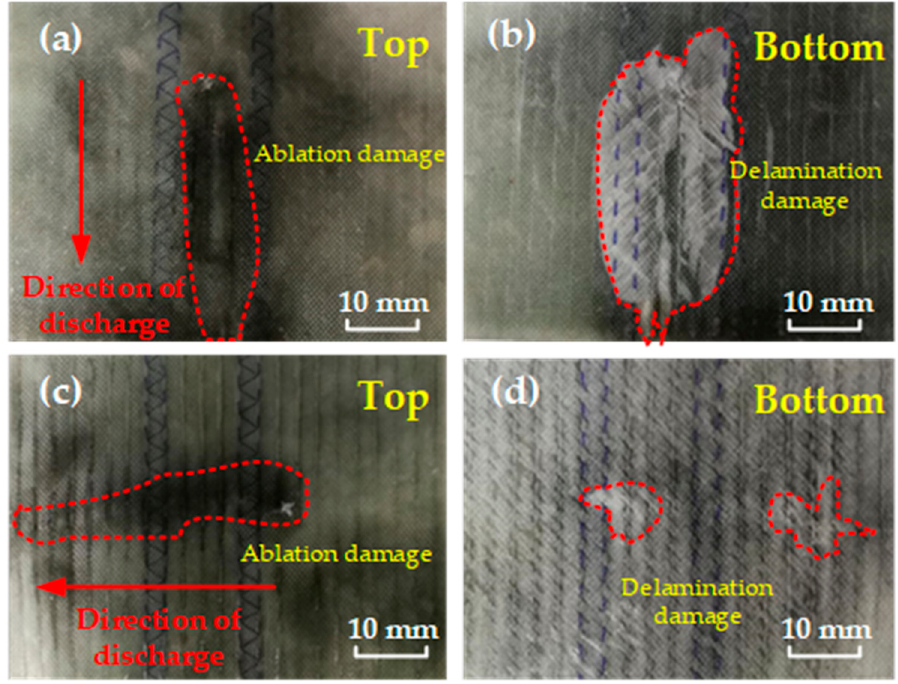
Figure 11. Damage area of the GFRCs under lightning current component A with an amplitude of 30 kA, ( a , b ) discharging along the fiber direction, ( c , d ) discharging perpendicular to the fiber direction.